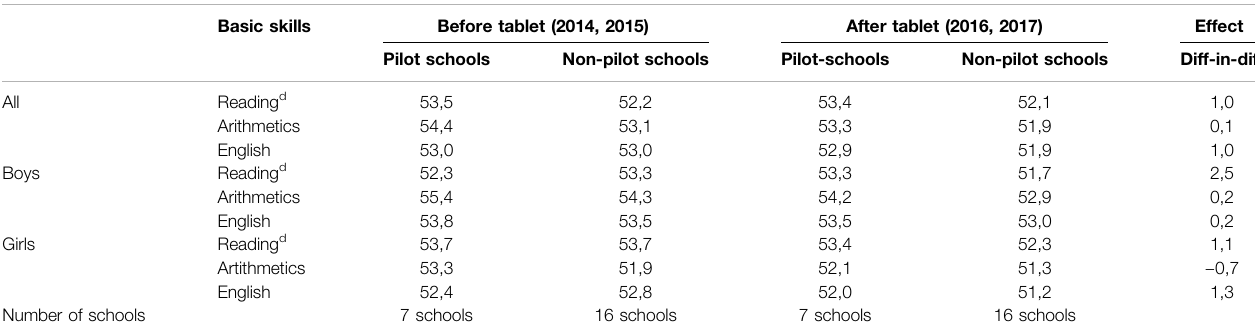
TABLE 3 | Difference-in-difference analysis of fi fth grade test results (Pilot 2